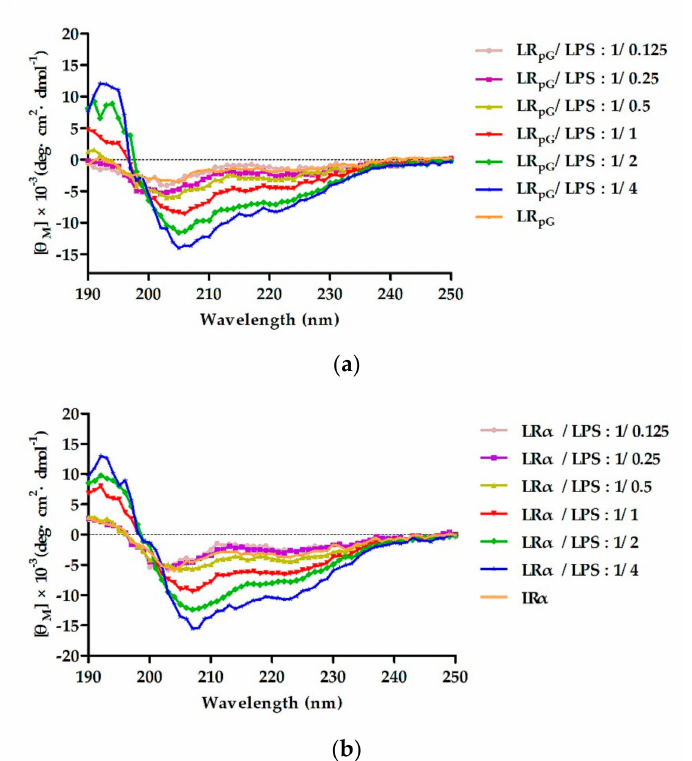
Figure 8. The circular dichroism (CD) spectra of ( a ) LR pG and ( b ) LR α were dissolved in di ff erent concentrations of lipopolysaccharide (LPS), and the peptide / LPS molar ratio ranged from 1 / 0.125 to 1 / 4. The average value after three scans of every sample is shown. The CD spectrum of LPS was